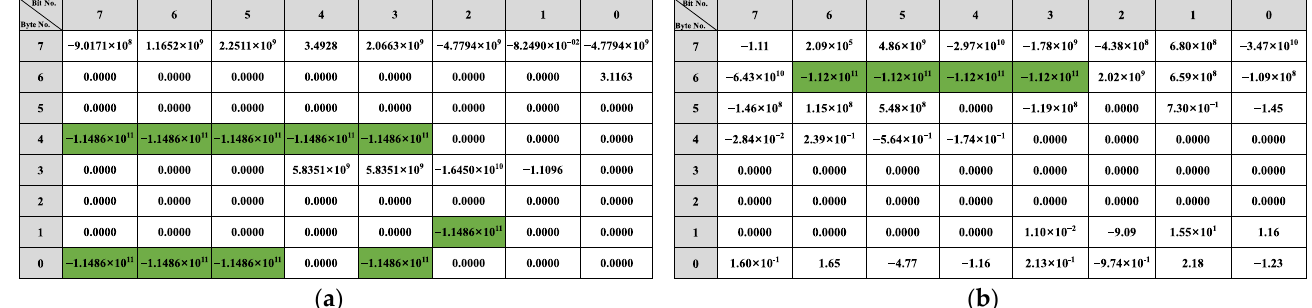
Figure 16. Gear-related messages reverse result: ( a ) ID 0x228 reverse result; ( b ) ID 0x165 reverse result.